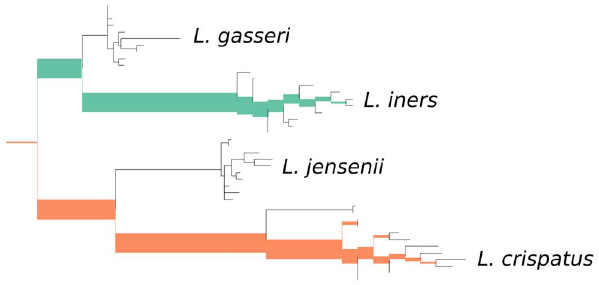
Figure 5. The second principal component for the combined vaginal data, representing about 24 percent of the variance. Low-weight regions of the tree are excluded from the figure. The edges across which maximal between-sample heterogeneity is found are those between two different Lactobacillus clades: L. iners and L. crispatus . Thus, the second important ‘‘axis’’ appears to correspond to the relative levels of these two species.